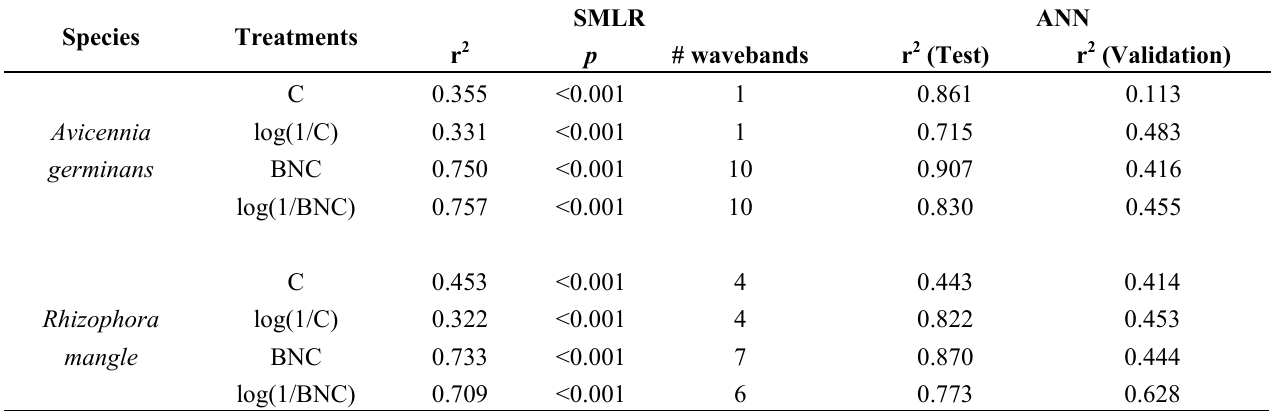
Table 2. Results of SMLR and ANN for N concentration